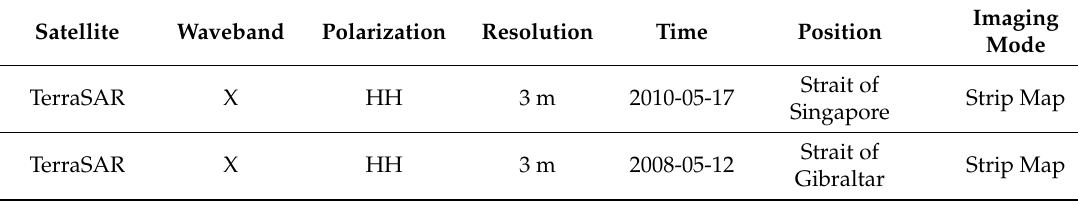
Table 1. The Information about the TerraSAR-X